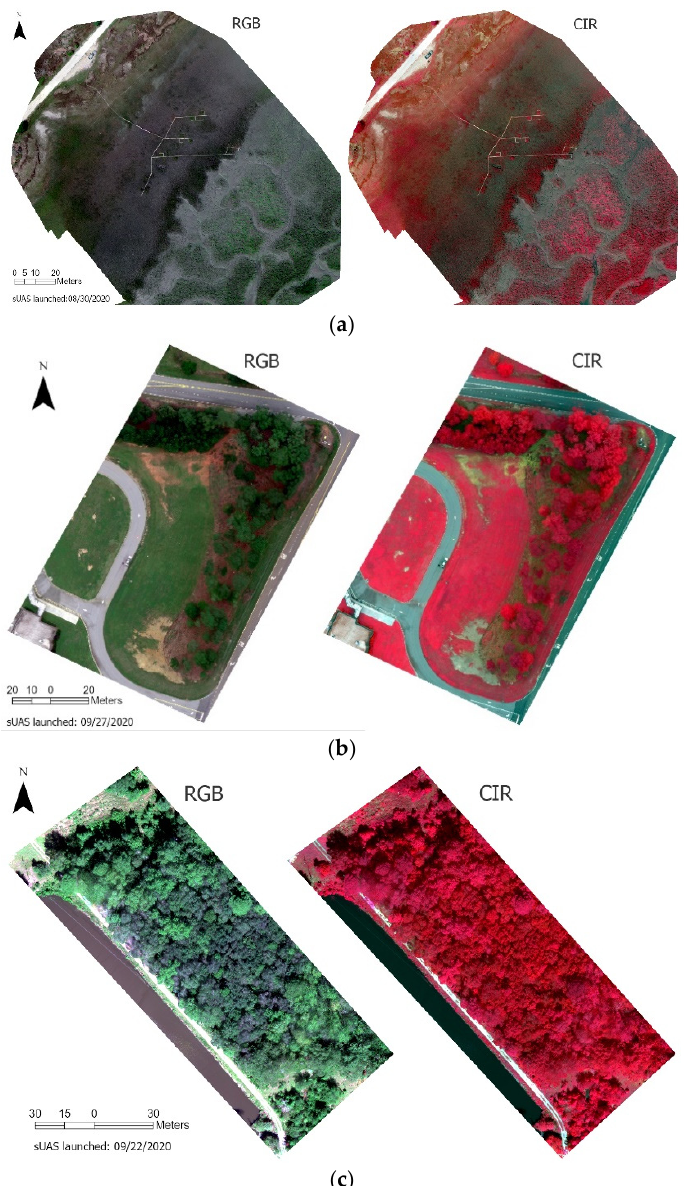
Figure 9. The RGB and CIR composites of the RedEdge-M surface reflectance orthoimages of marsh ( a ), grass ( b ), and forest ( c ).